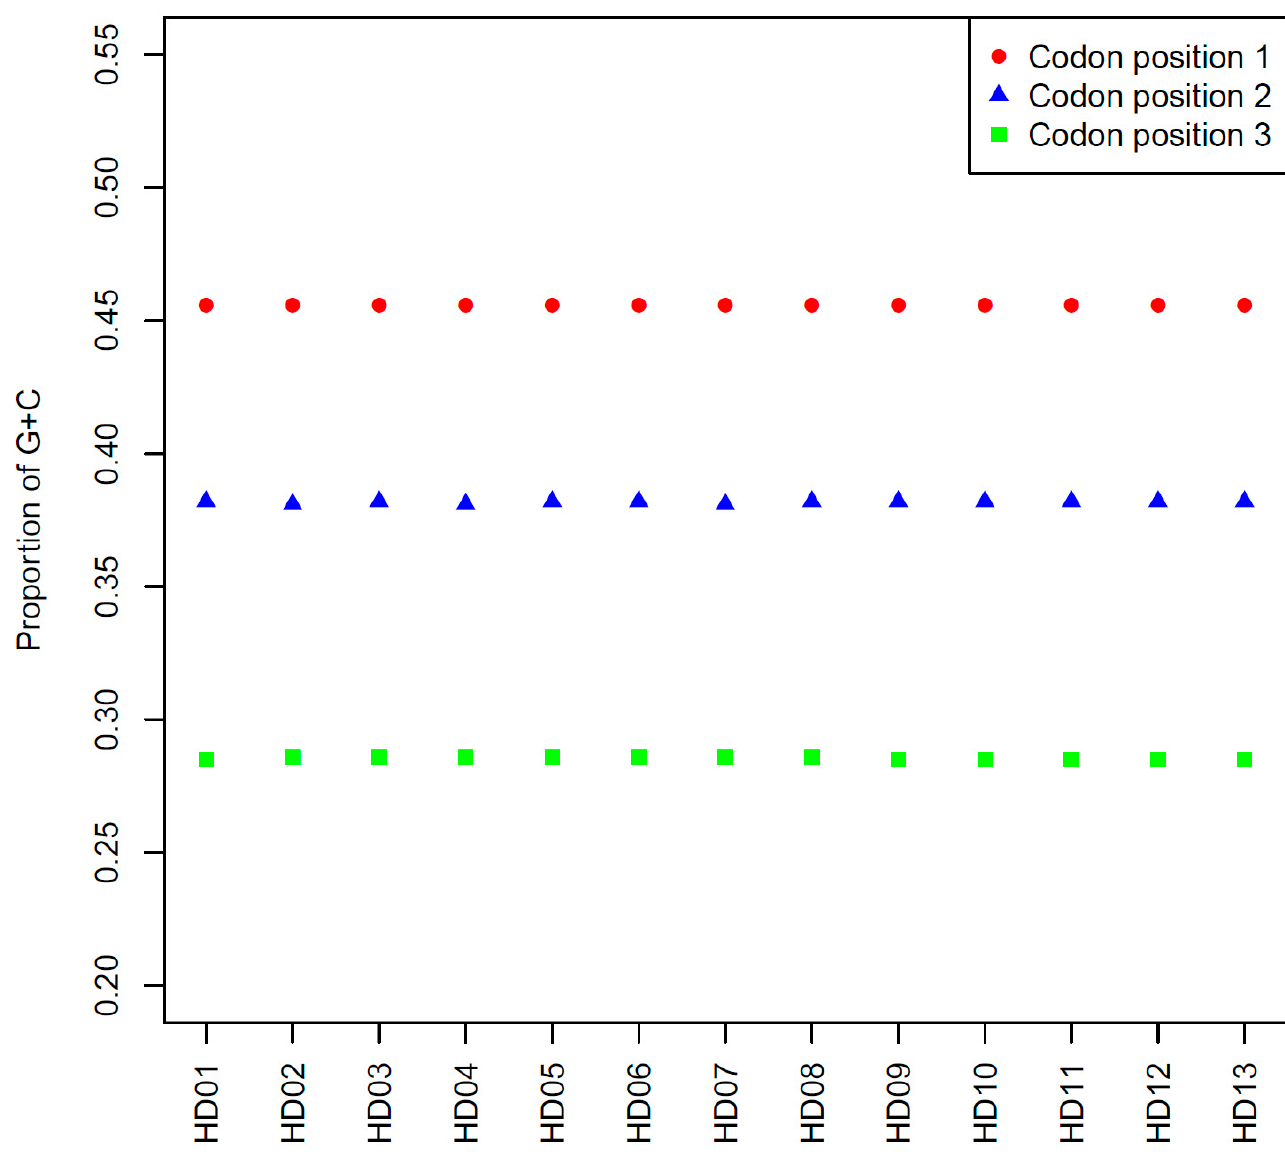
Figure 1. Comparison among the average contents of GC at the di ff erent codon positions in the cpDNA of the various samples.